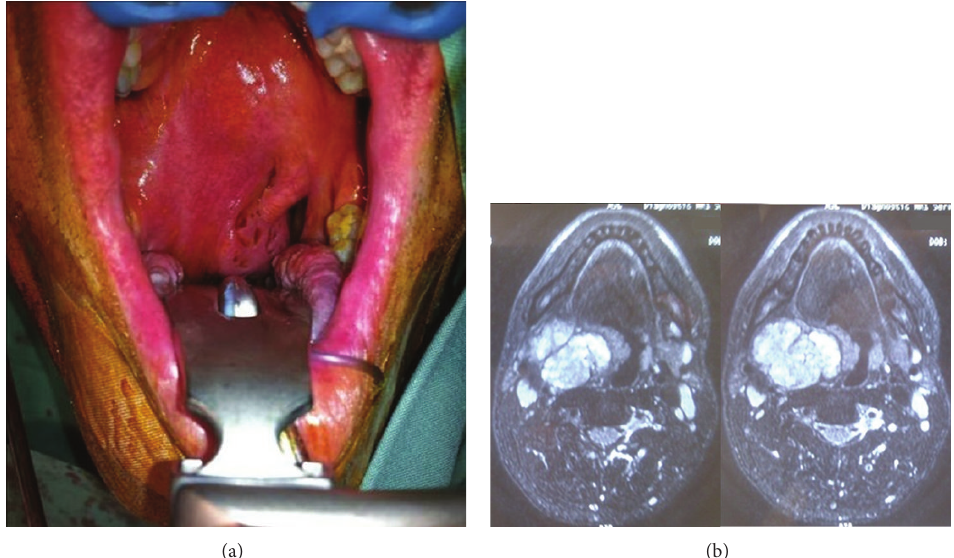
Figure 1: (a) The soft palate is displaced anteromedially by the parapharyngeal mass. (b) Magnetic resonance imaging of the parapharyngeal mass showing a lobulated, homogeneous mass.